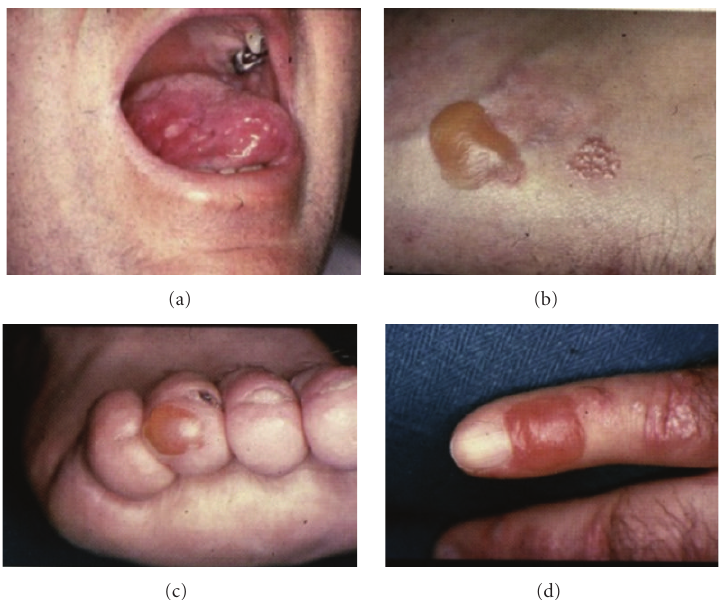
Figure 3: Epidermolysis bullosa aquisita. (a) Erosions in the oral cavity in EBA. (b) Blisters on the wrist in EBA. ((c) and (d)) Blisters on the fingertips in EBA.